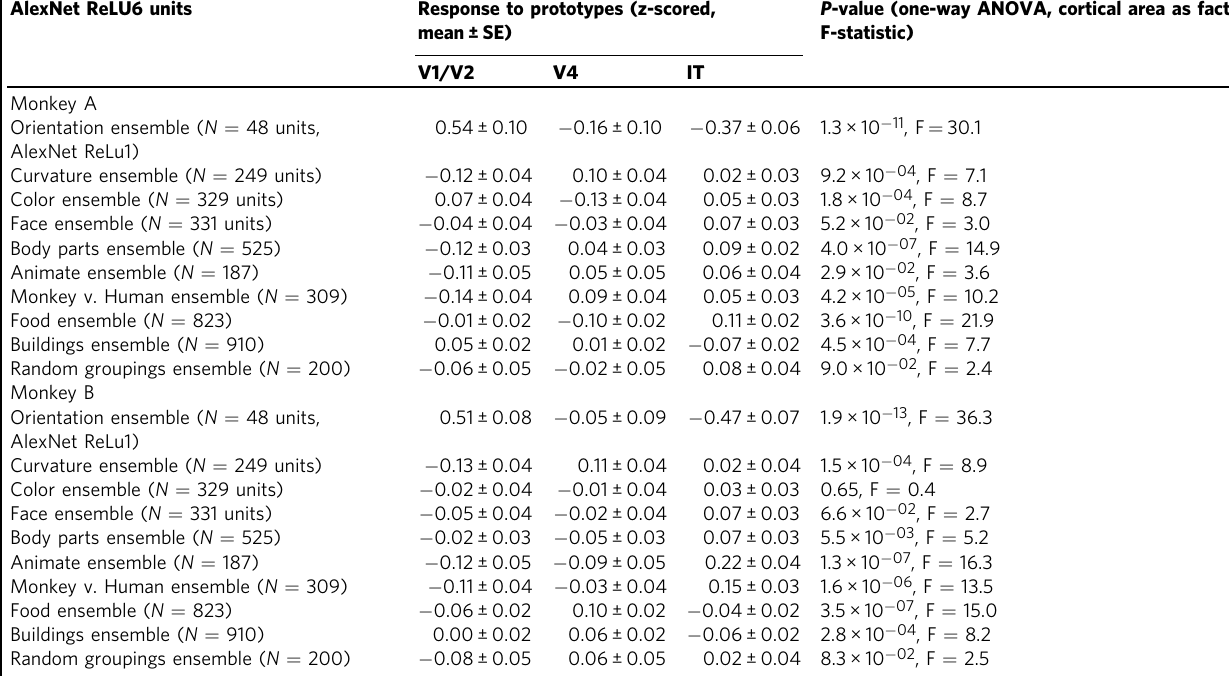
Table 4 Prototype interpretation via semantic ensembles. AlexNet ReLU6